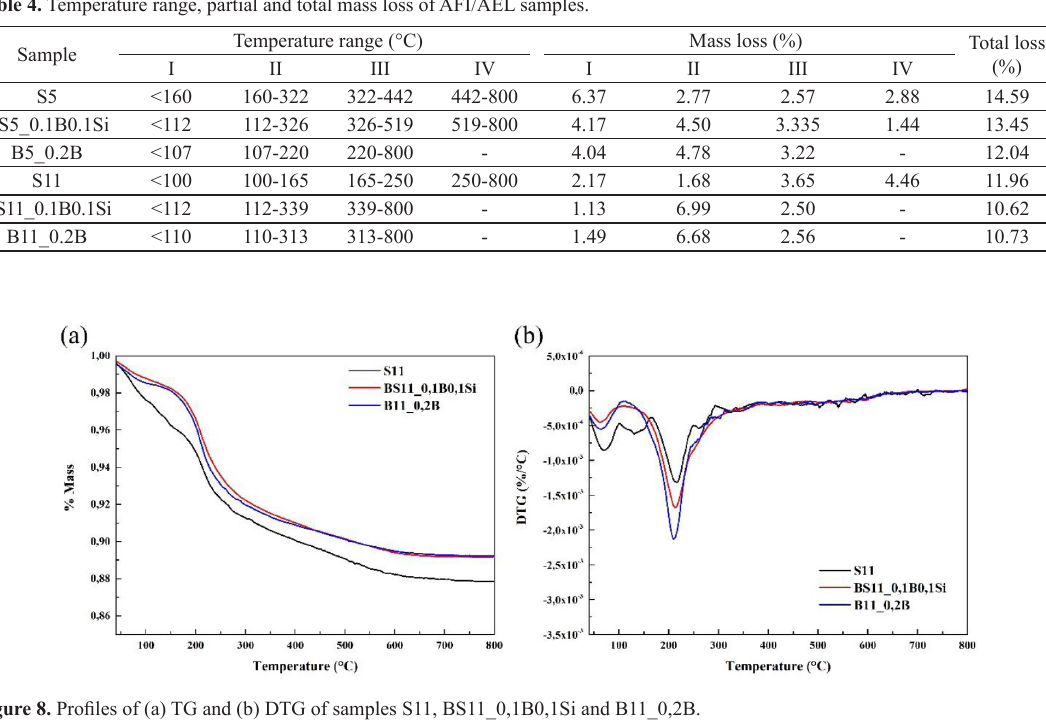
Figure 9. TPD-NH